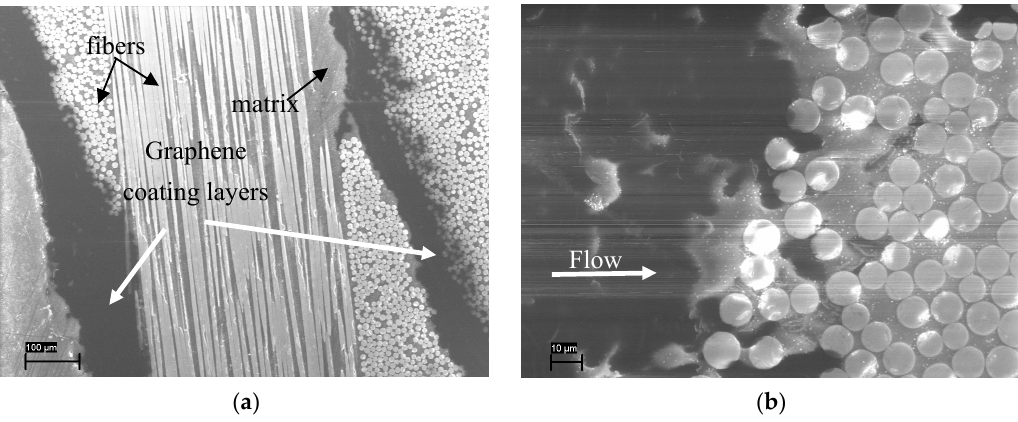
Figure 8. Transient permeability results of different percentages of graphene coated glass fiber reinforcement.